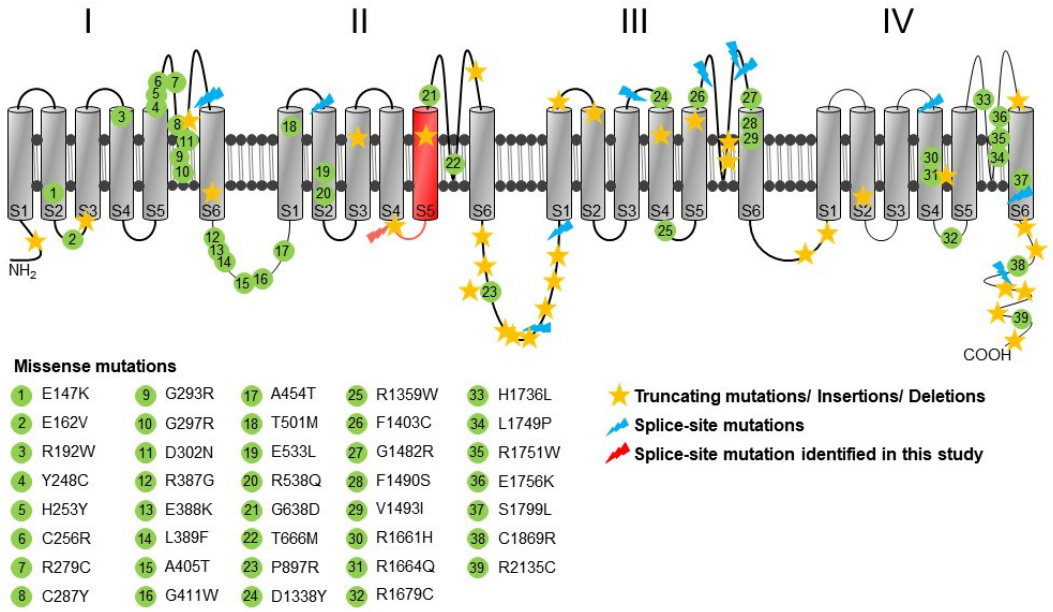
Figure 3. Localization of the identified splice-site mutation. Membrane topology of a Cav2.1 channel showing the predicted structure which includes four homologous domains (I–IV) with six transmembrane segments (S1–S6) in each domain. The position of the novel c.1913 + 2T > G variant is indicated as a red mark at the beginning of the S4–S5 linker of the II domain. Highlighted in red are shown the regions of the Cav2.1 channel that are predicted to be missed as a result of the mutation. The diagram also shows the localization of single nucleotide substitutions, truncating and splice-site mutations in the secondary structure of the Cav2.1 α 1 subunit. All CACNA1A missense, nonsense, and splice-site mutations that are depicted in the figure were collected from the HGMD database.